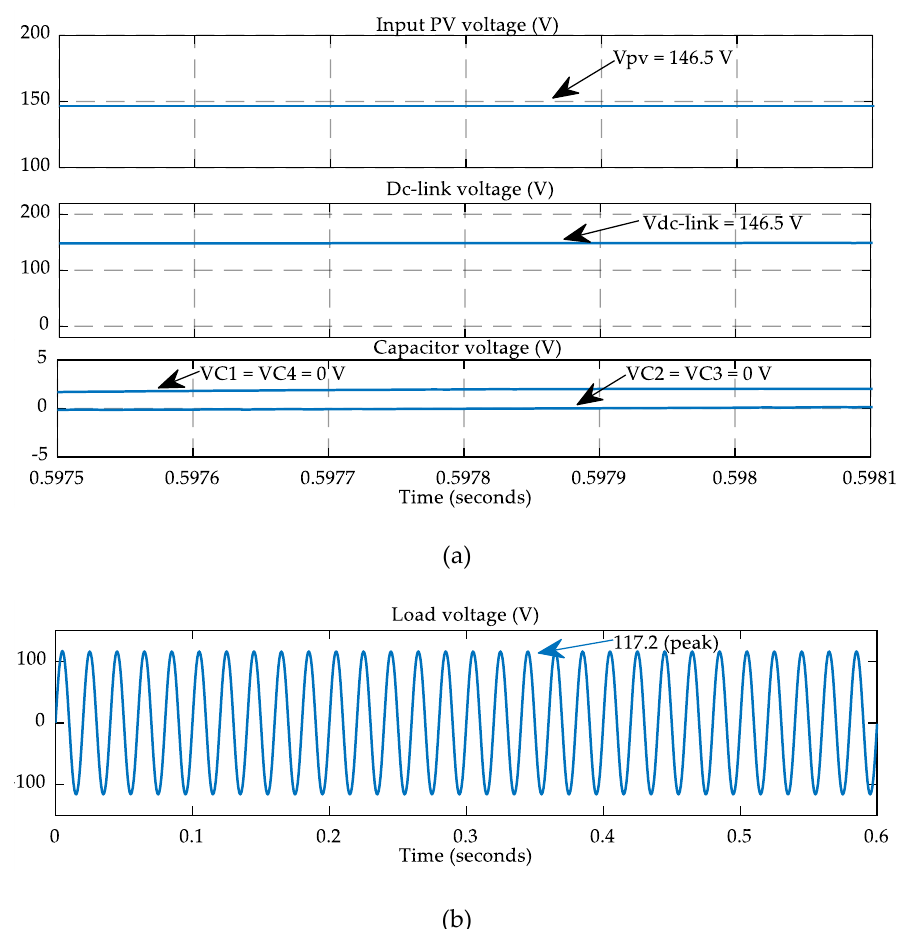
Figure 8. Simulation results during normal PWM state: ( a ) output voltage of the PV unit, DC-link voltage, and capacitor voltages; and ( b ) output load voltage.